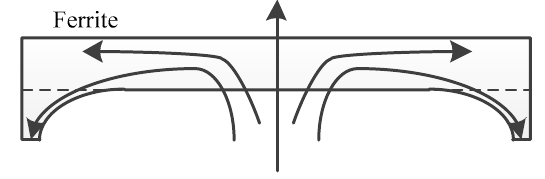
Figure 22. Structure of the proposed shield.